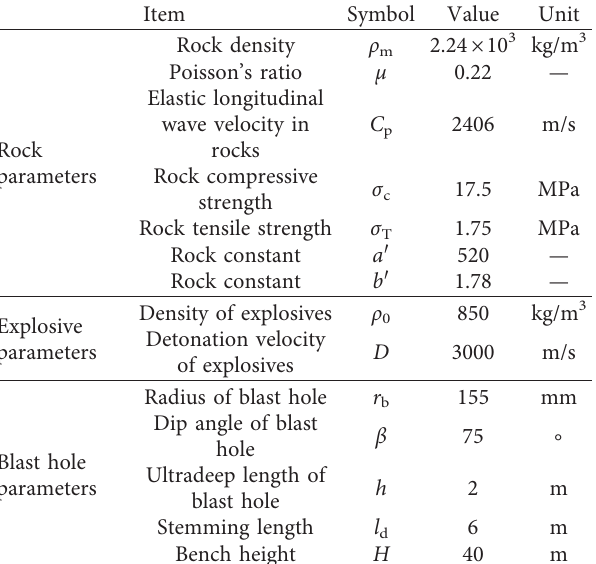
Figure 7: Schematic diagram of the distance between two adjacent blast holes. Table 5: Relevant calculation